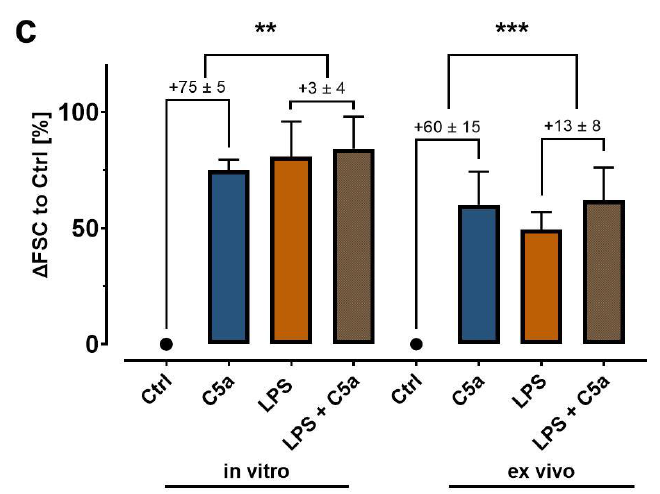
Figure 6. Simplified simulation of sepsis in vitro and in a clinically relevant ex vivo whole blood model. Isolated neutrophils (left) or whole blood (right) was incubated with 100 ng/mL LPS for 60 min followed by subsequent stimulation with 100 ng/mL C5a revealing alterations in the response pattern in ( a ) depolarization, ( b ) intracellular alkalization, and ( c ) changes in cellular size ( n = 5–8, ** = p < 0.01, *** = p < 0.001, Mann–Whitney test). Ctrl and LPS data partially overlap from a previous publication